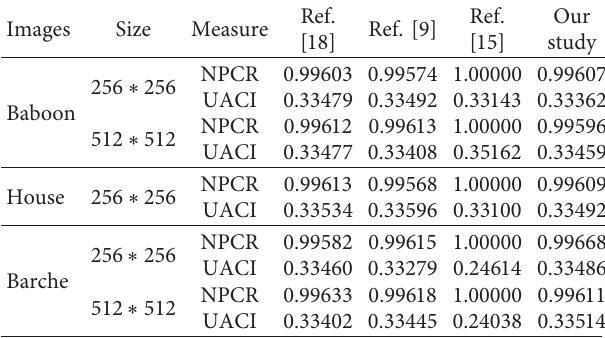
; (b) encryption result of key ; (c) difference of (a) and (b); (d) 1 2 Table 4: NPCR and UACI